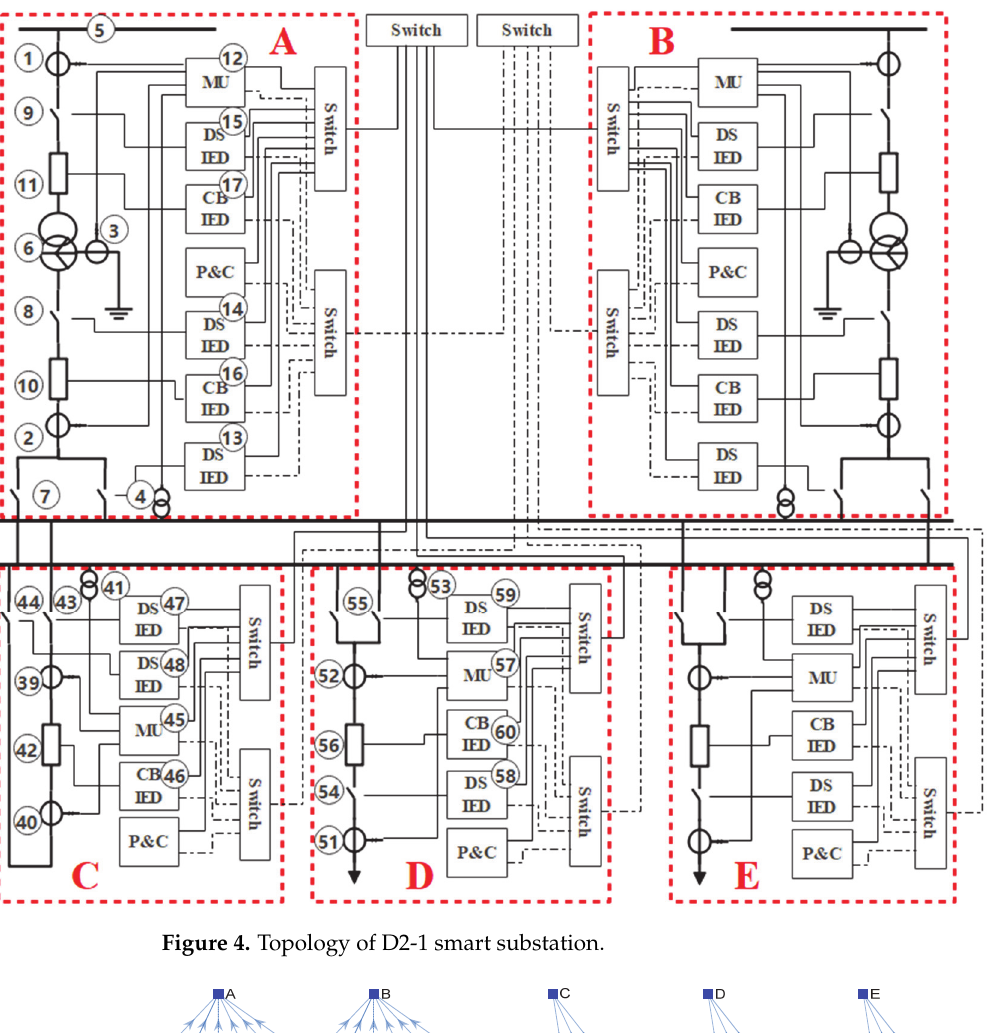
Figure 4. Topology of D2-1 smart substation.